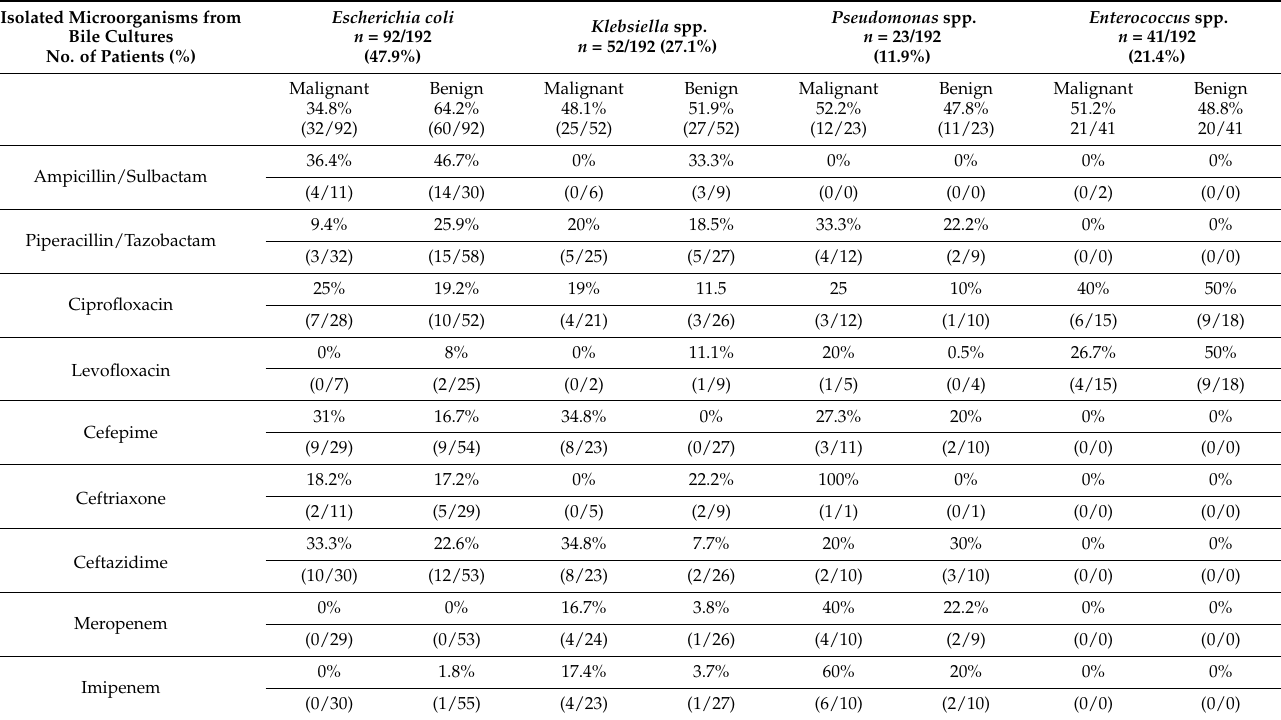
Table 7. Evaluation of bacterial resistance to antibiotics from bile culture in patients with acute